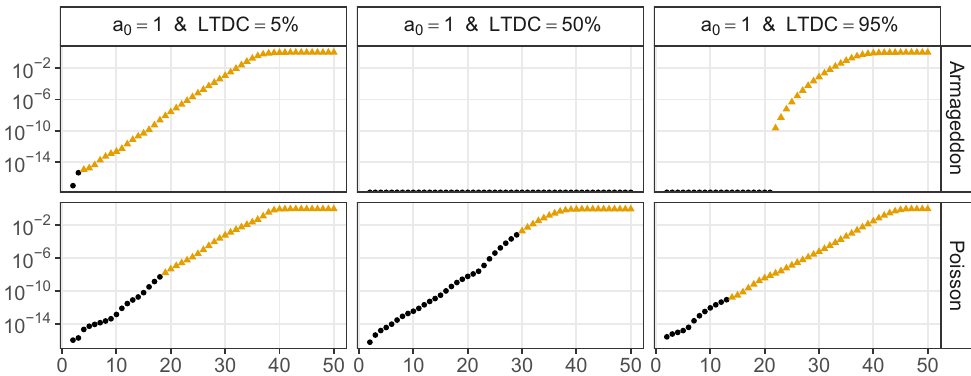
Figure 2: The maximum total variation distance ( ) ε d 2 of the transition distributions of naïve approximation and high - precision calculation of ∗ Q for ≤ ≤ d 2 50 ; yellow coloring and triangle shape indicate whether fl ooring was